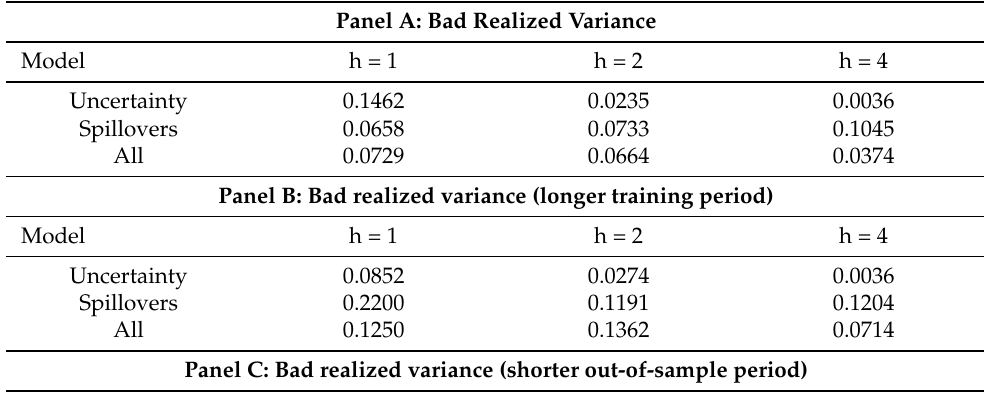
Table 3. Forecasting results for upside and downside